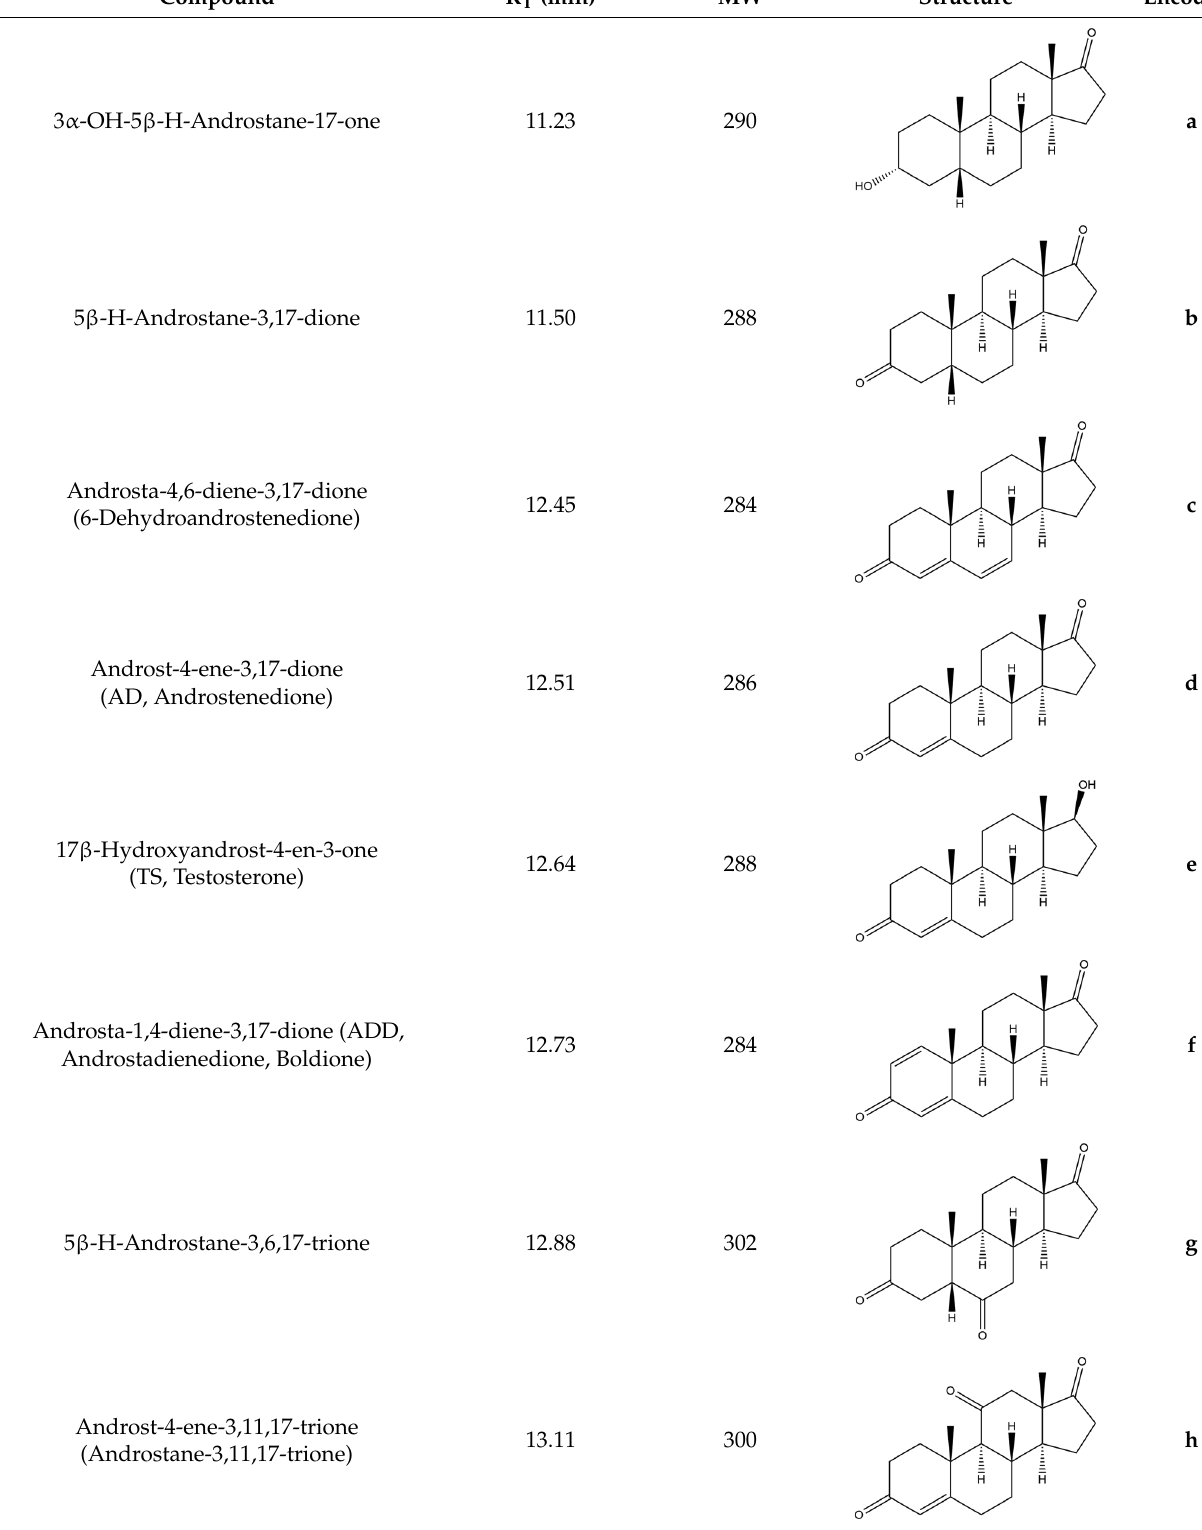
Table 1. GC/MS values and structures of steroid substrate and bioconversion products formed with filamentous fungi-destructors of tempera painting materials.